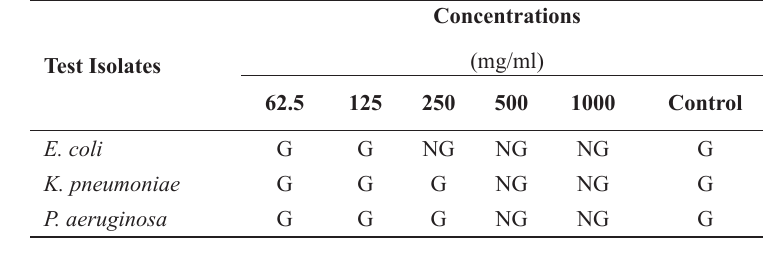
Table 4: Minimum inhibitory concentration of Honey ( Apis mellifera ) on test organisms.